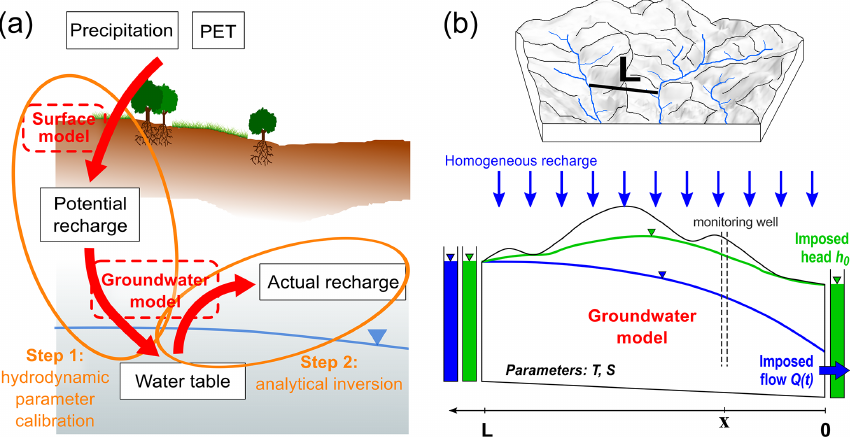
Figure 1. (a) Description of the method to estimate recharge from observed water table fluctuations. Step 1 infers groundwater model param- eters using potential recharge estimates as input. Step 2 consists in estimating actual recharge from observed water table fluctuations using parameters (obtained from Step 1) in an analytical inversion. PET refers to potential evapotranspiration. (b) Description of the homogeneous 1D groundwater flow model. Recharge rate, R(t) , is uniformly distributed along model length L . Model boundary conditions are a constant head at x = L and either a constant head or imposed flow rate at x = 0 in order to represent natural (green case) and pumped systems (blue case). Note that the aquifer is assumed to be of uniform thickness with confined behavior under the Dupuit assumption so that the aquifer thickness does not matter in the